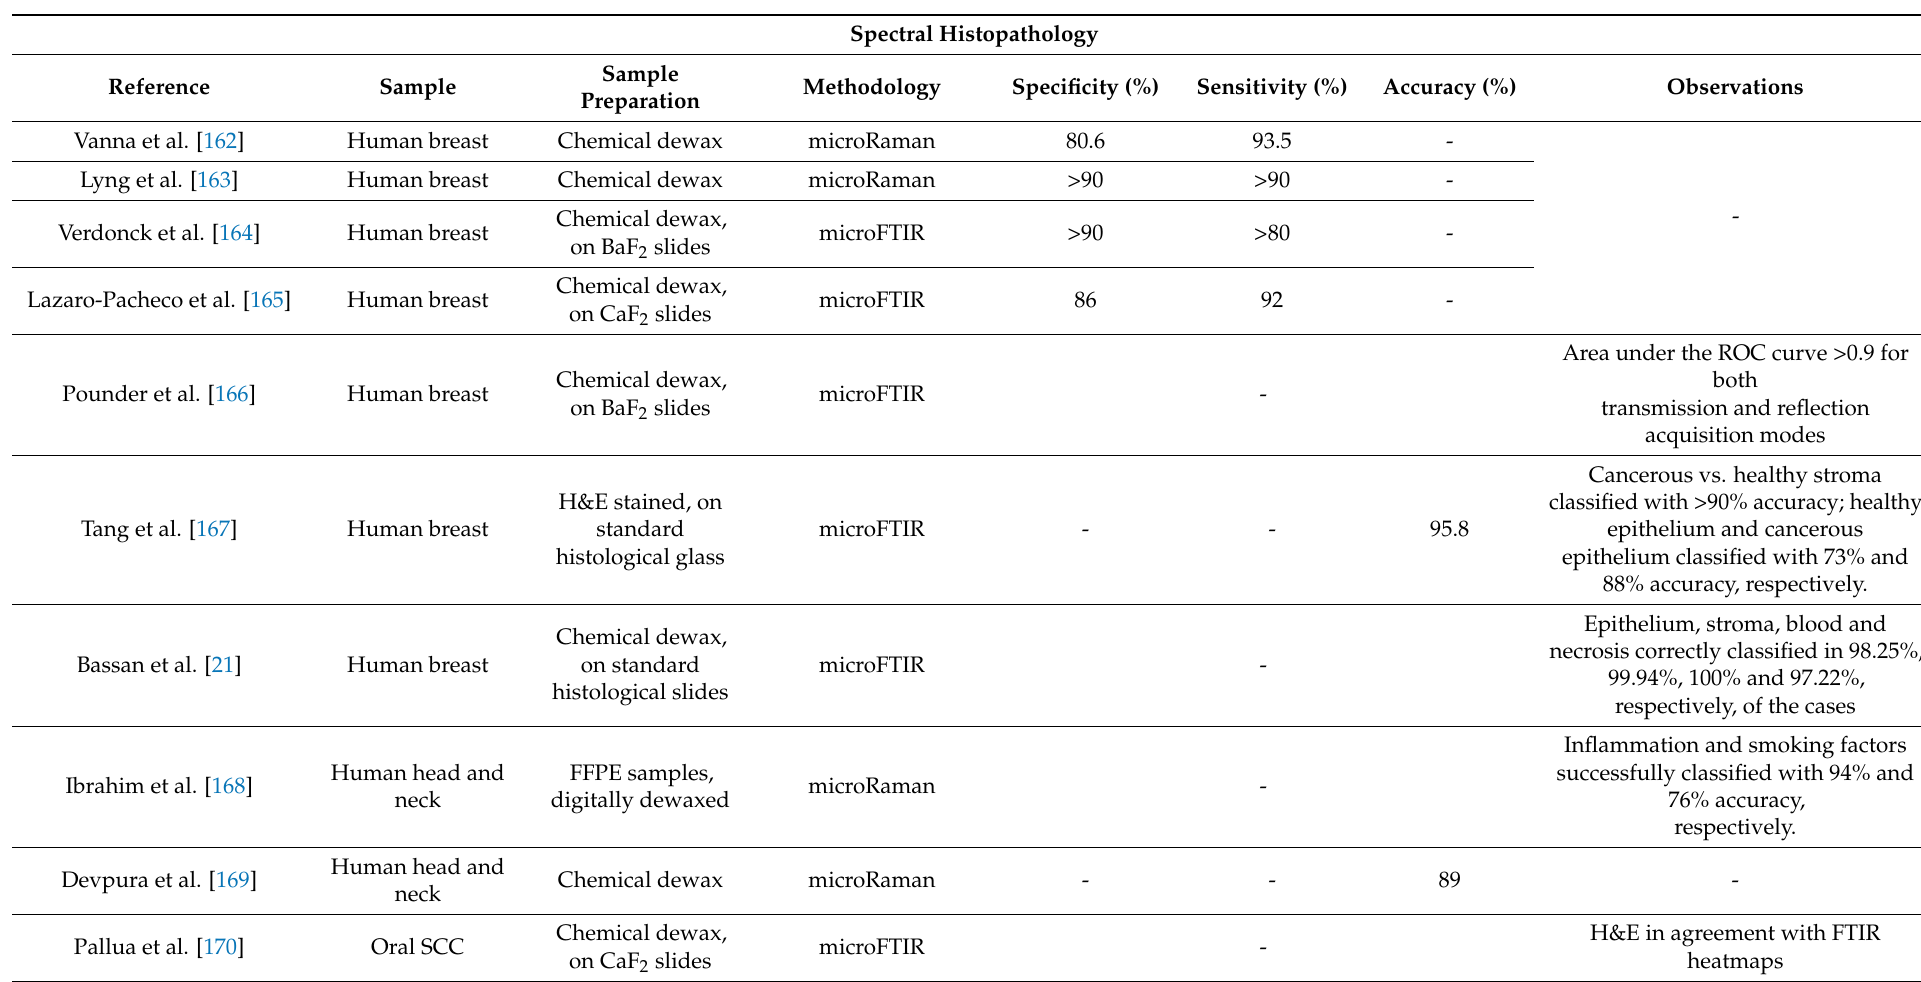
Table 3. Summary of the research studies included in this review article, performed with Raman and FTIR spectroscopy regarding spectral histopathology, according to the type of sample, sample preparation, methodology and specifications